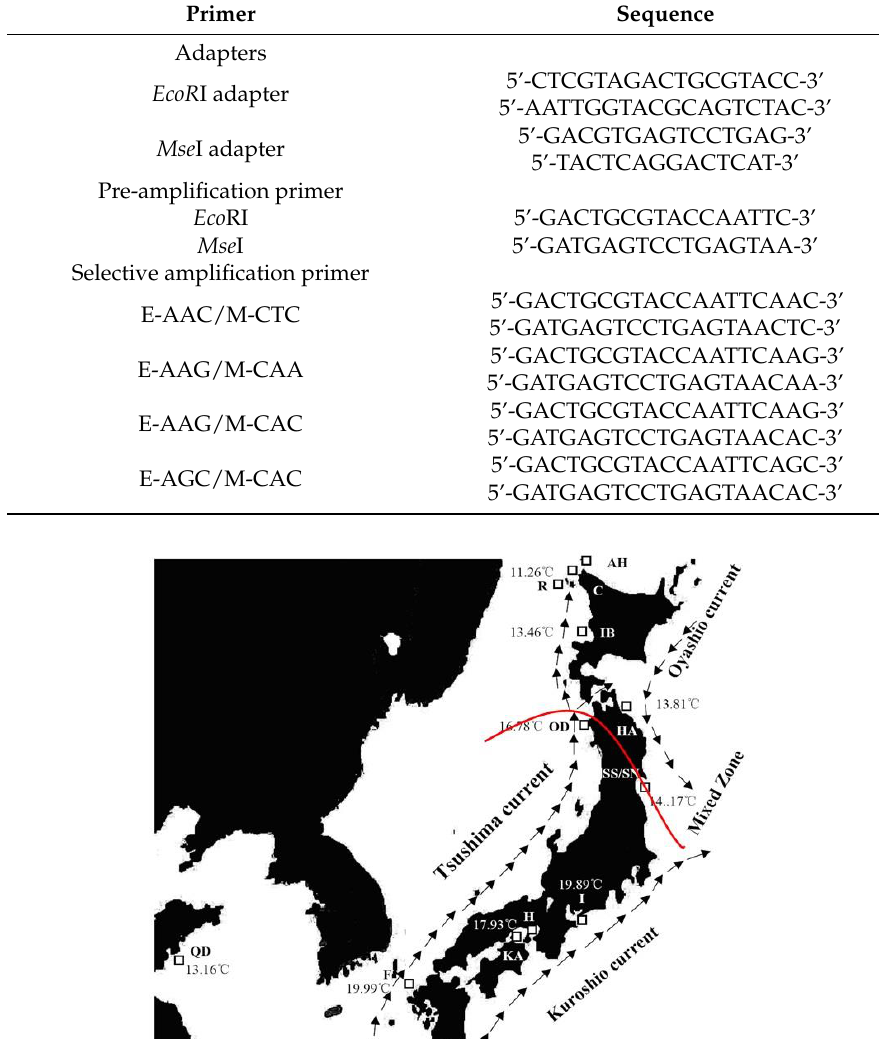
Table 2. Adaptor and primer sequences used in the AFLP analysis.